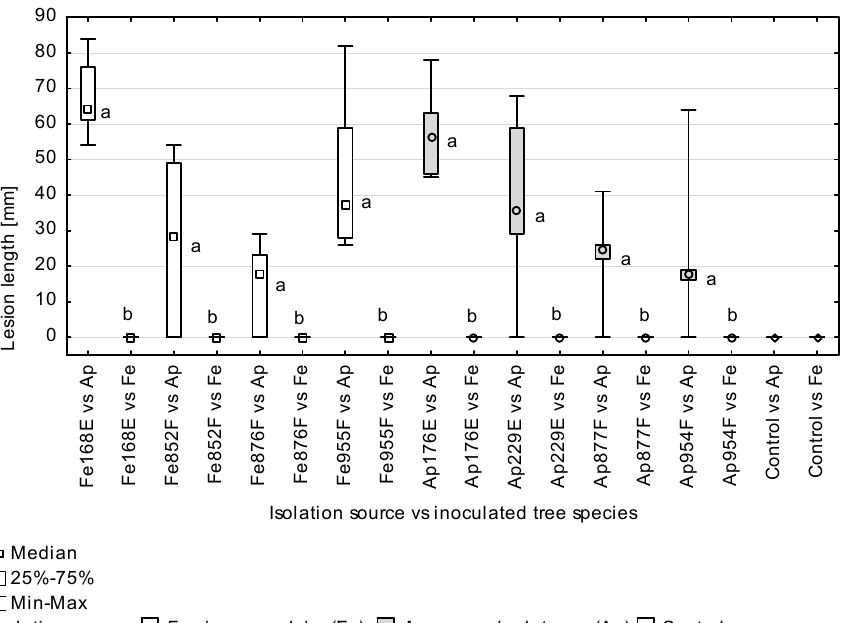
Figure 11. Lengths of necrotic lesions on Fraxinus excelsior (Fe) and Acer pseudoplatanus (Ap) petioles inoculated with Apiognomonia hystrix isolates originating from Fraxinus excelsior and Acer pseudoplatanus , eight weeks post inoculation. Values within groups (created by combining the data for the same isolates) marked with different letters indicate statistically significant differences between host species according to the Mann–Whitney U test with significance threshold α = 0.05.